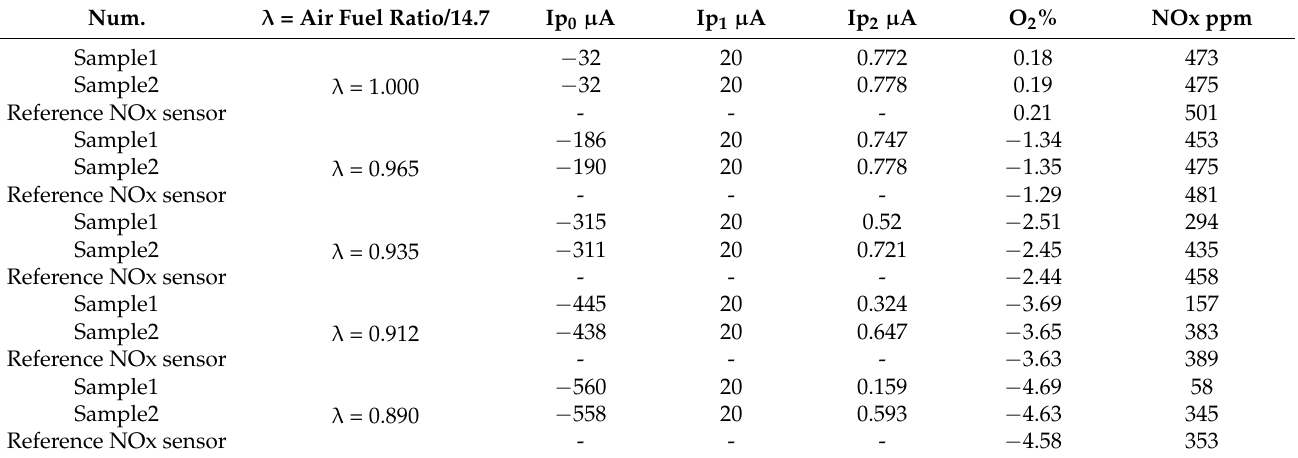
(sample1 has high-activity P − electrode, sample2 has low-activity P − electrode).